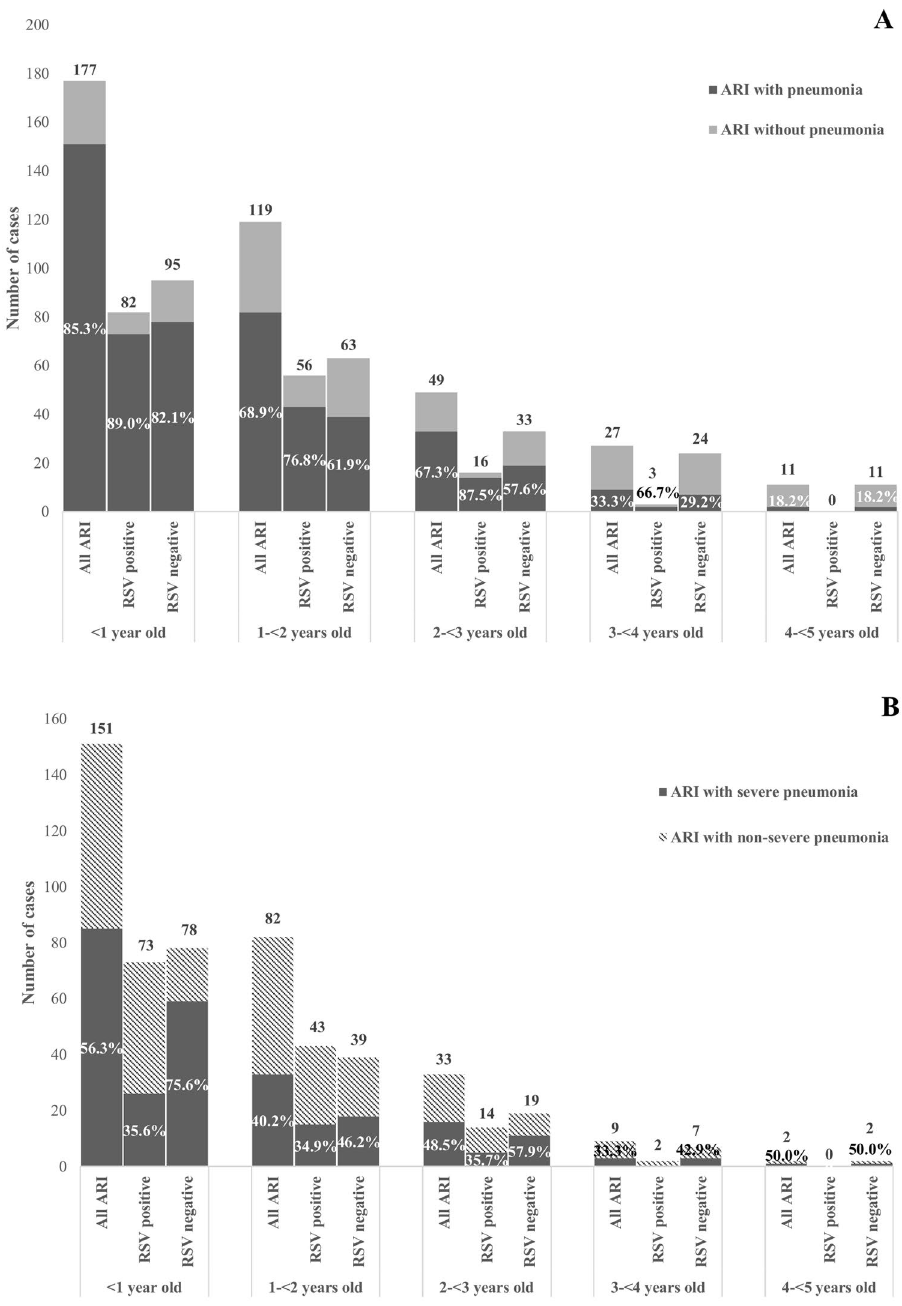
Figure 1. Distribution of ARI patients, with or without pneumonia, by age groups according to RSV status. ( A ) Proportion of pneumonia among ARI patients. ( B ) Proportion of severe pneumonia among ARI patients with